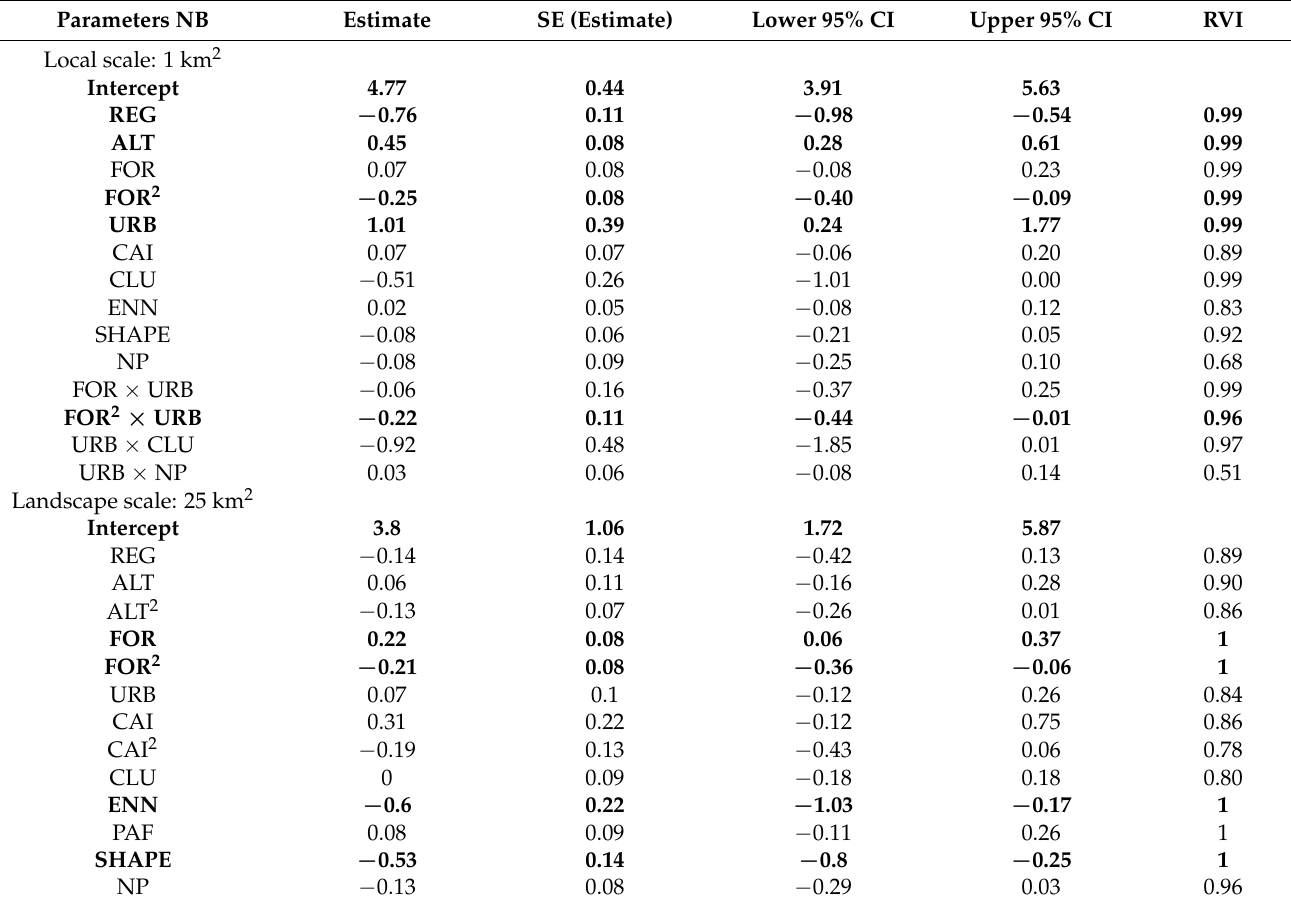
Table 3. Conditional model averaging of the top-ranked models (delta AICc < 2), examining the effect of predicted factors on the abundance of tawny owls. Model average parameter estimates, adjusted standard errors, 95% confidence intervals, and relative variable importance (RVI, the sum of Akaike weights across the set of models in which the variable appears) are shown. Effects with 95% CI not overlapping zero are shown in